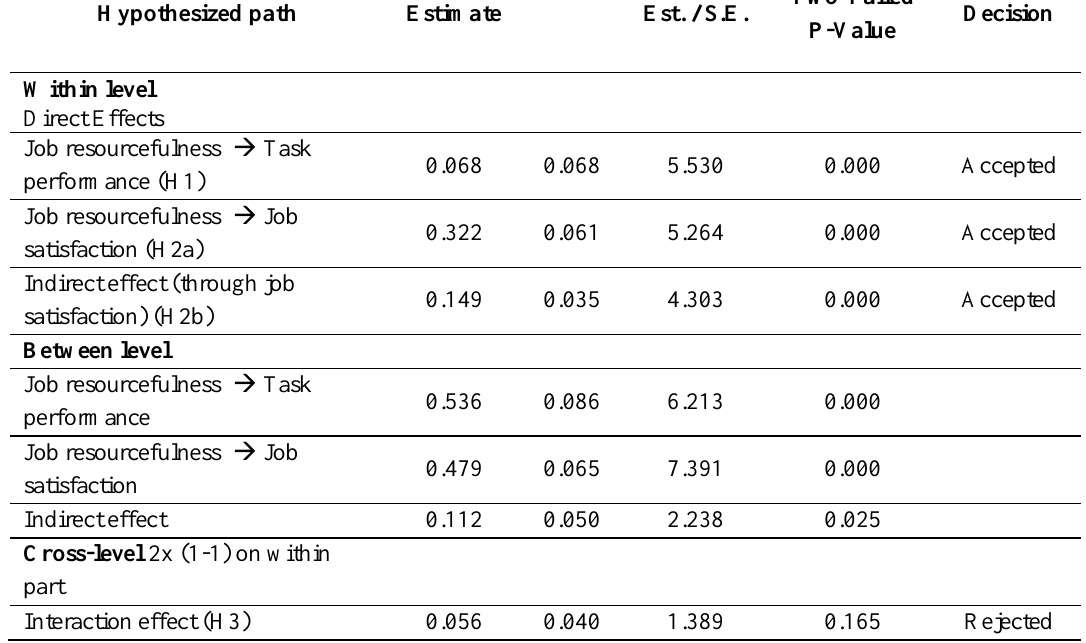
Table.2.Unstandardized Path Coefficients and Standard